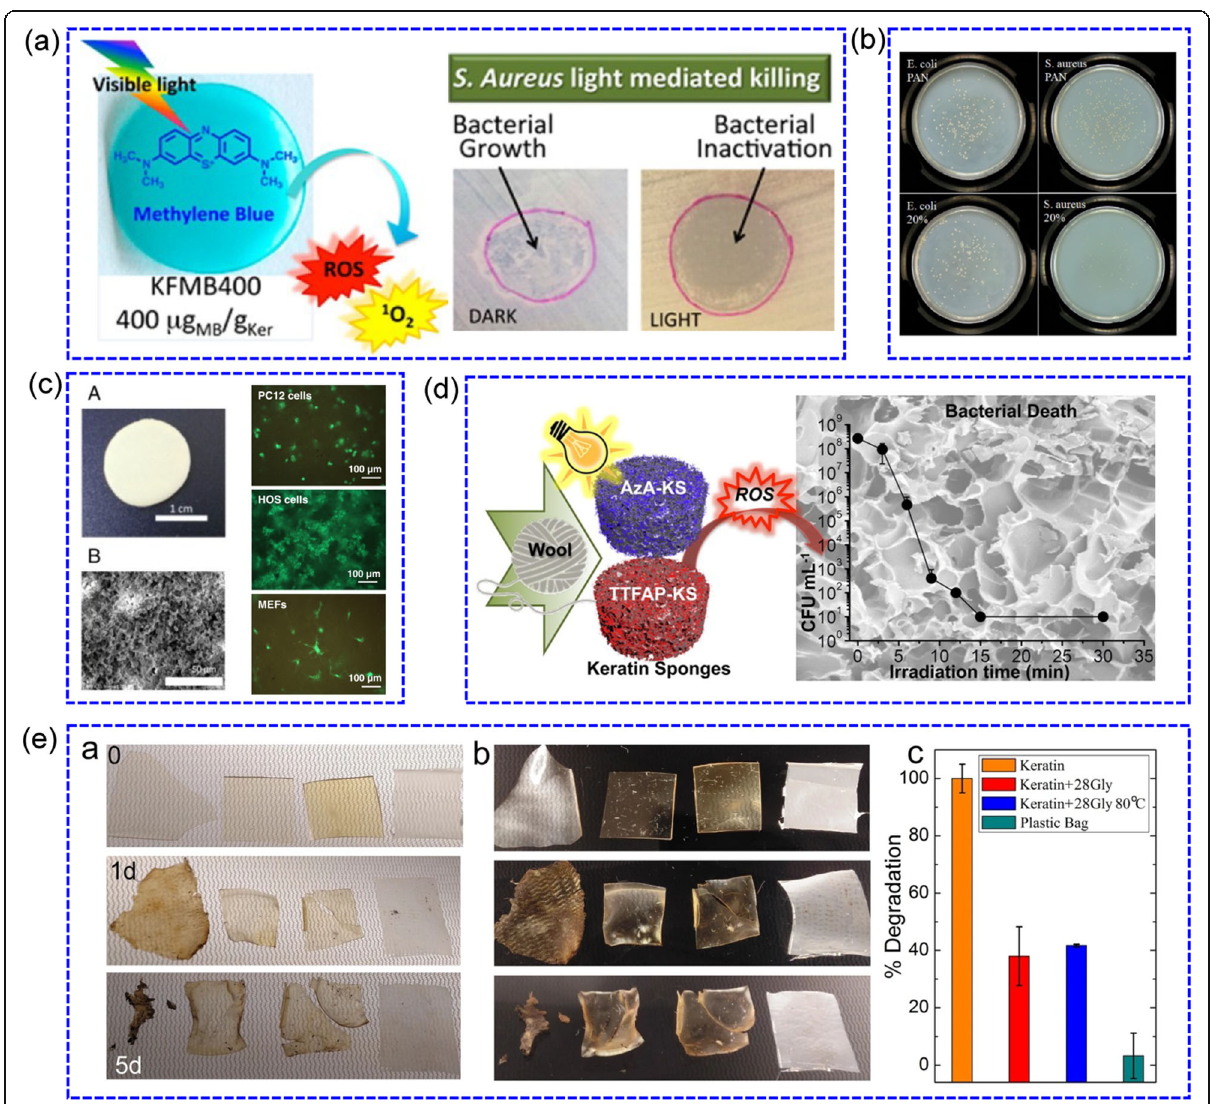
Fig. 8 (a) Keratin films doped with methylene blue and its antimicrobial test; (b) Antibacterial test of wool keratin/IL/PAN composite; (c) Morphologies and live/dead fluorescent assay of keratin hydrogel; (d) Wool keratin 3D scaffolds with light-triggered antimicrobial activity; (e) Keratin bioplastic films and the weight of degraded bioplastic after 5 days at composting conditions for the four representative materials [69 – 73]. Reprinted with permission from Reference [69]. Copyright 2015, American Chemical Society. Reprinted with permission from Reference